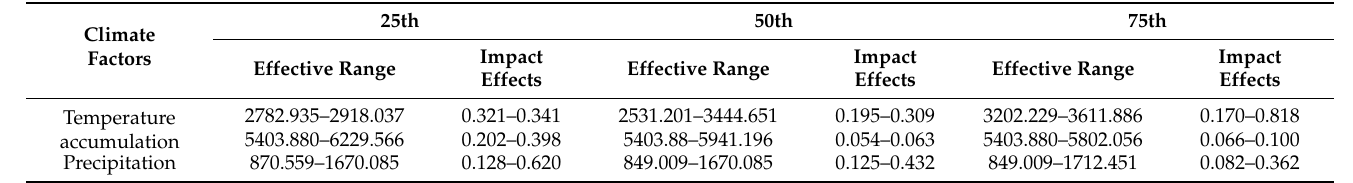
Table 5. Effective range of climatic factors contributing to the distribution of rice.